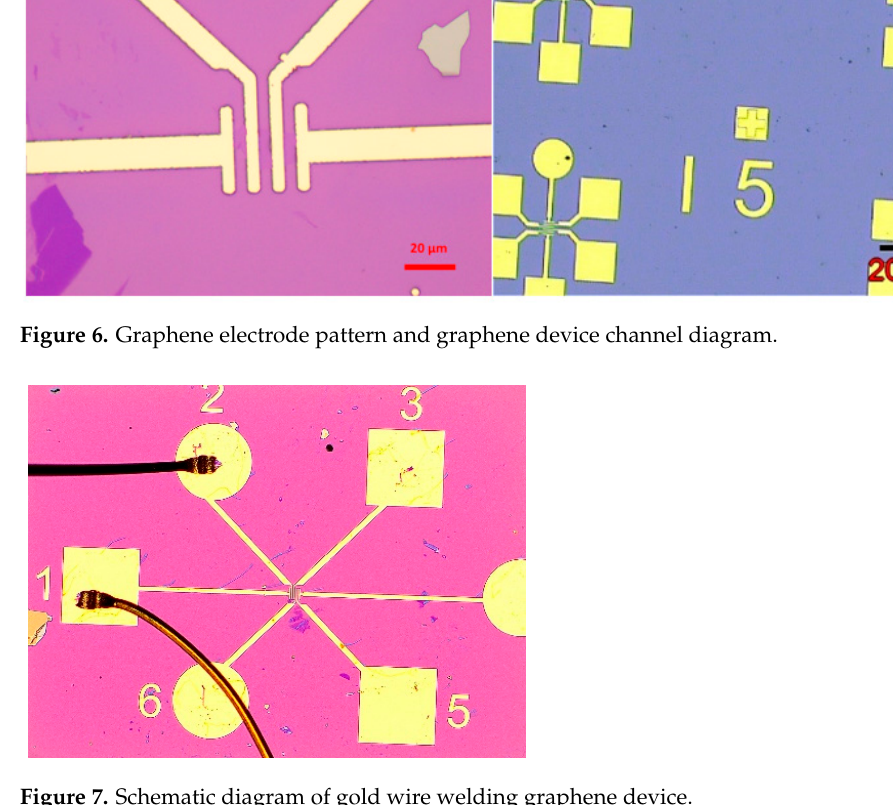
Table 2. Electron irradiation experimental